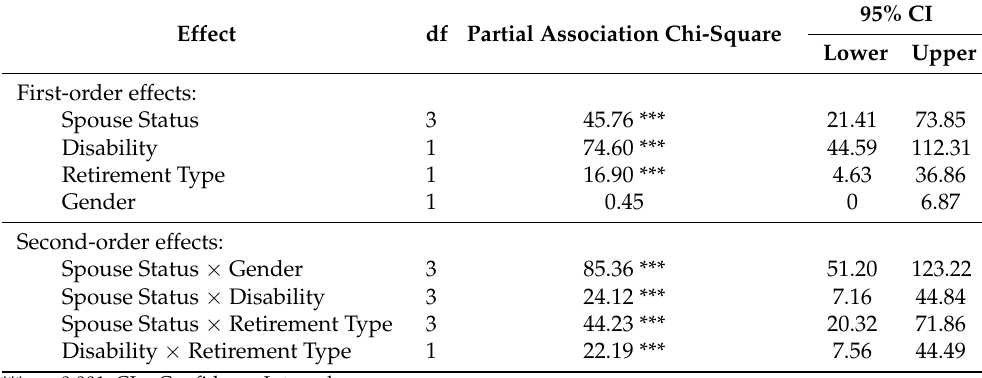
Table 2. Significance tests for hierarchical model of socio-structural drivers of retirement, n = 1179 over a four-year period.